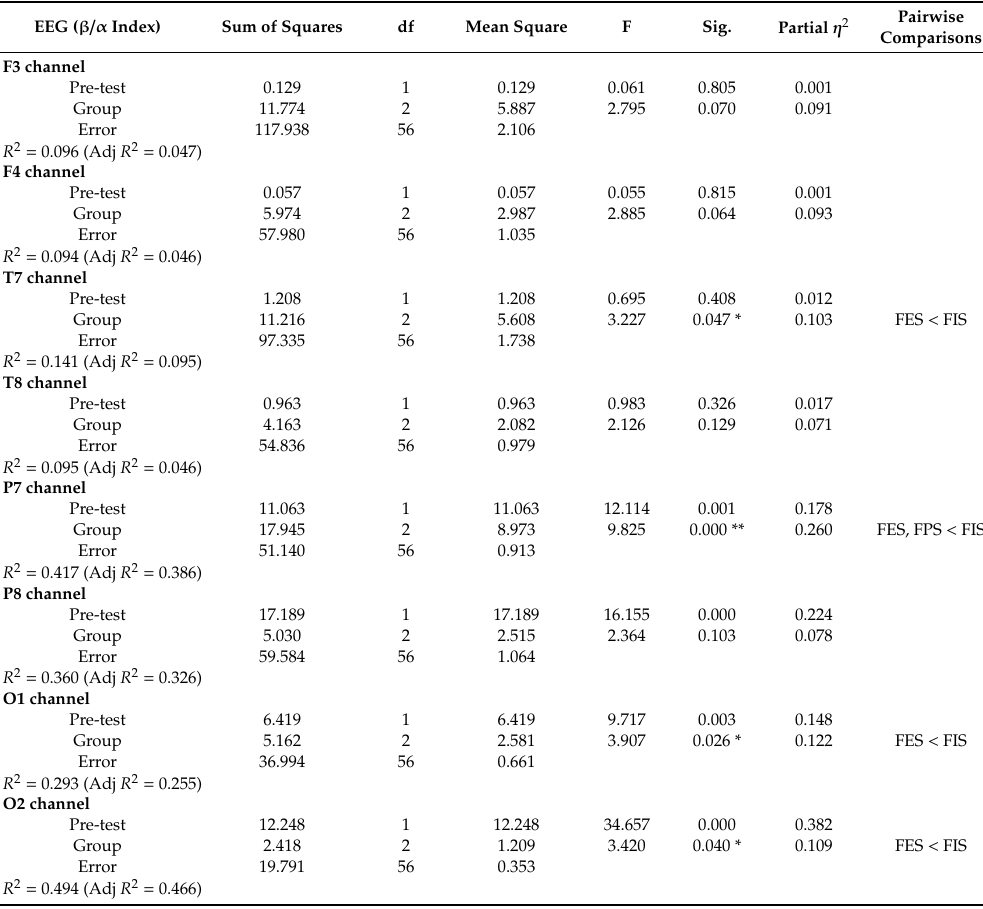
Table A1. E ff ect of bamboo forest space on EEG ( β / α index) across the experimental groups (covariates: pre-tests; dependent variables: post-tests).